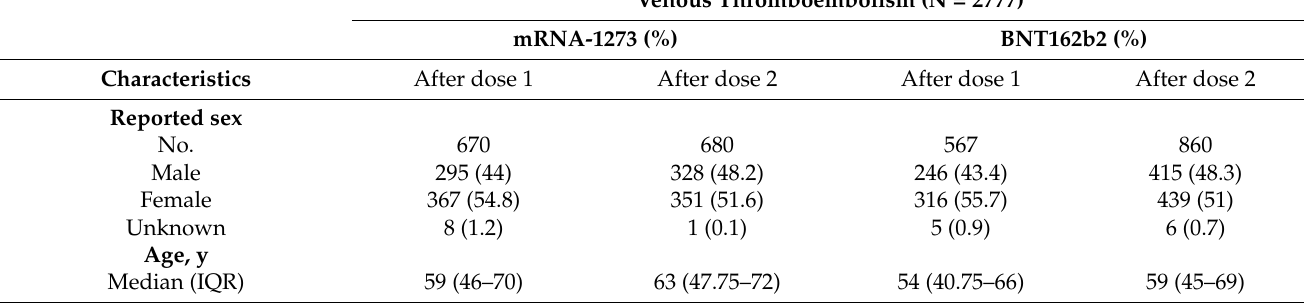
Table 1. Demographics of venous thromboembolism reports after COVID-19 mRNA vaccination, as of 28 January